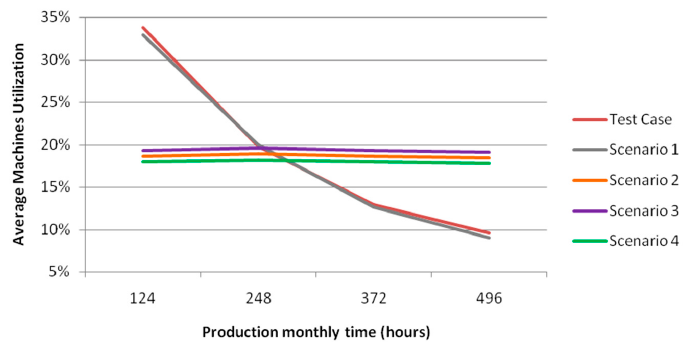
Figure 10. Scenarios performance in relation to machines utilization, as presented preliminarily in Reference [23].